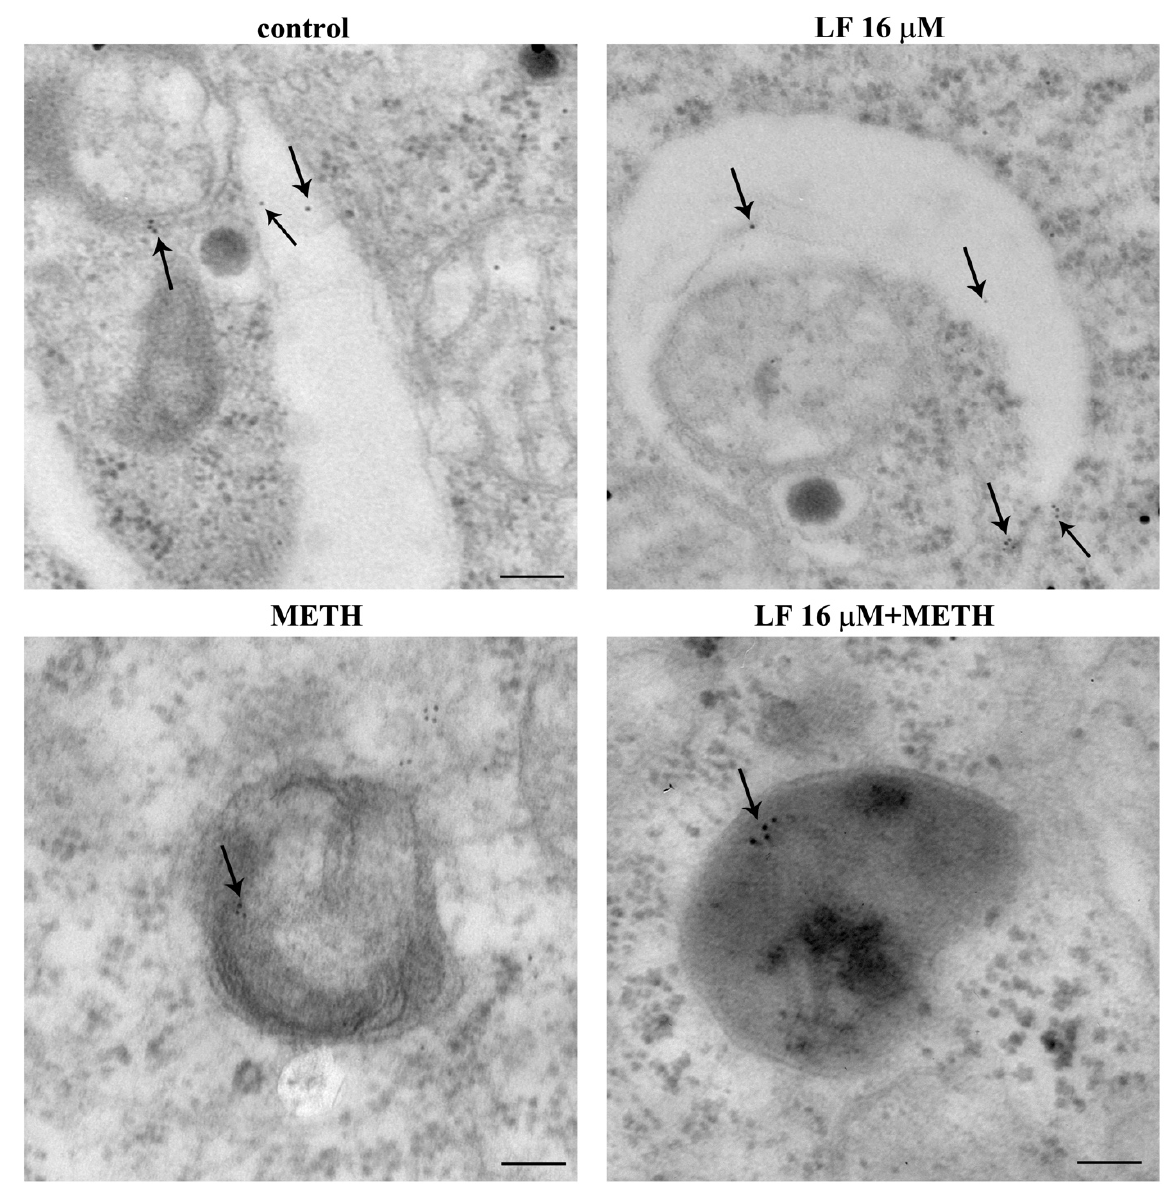
Figure 15. Lactoferrin increases LAMP1 compartmentalization within vacuoles. Representative TEM pictures of LAMP1 positive vacuoles from a control cell, and cells treated with either LF 16 µ M or METH or LF + METH. Arrows point to LAMP1 immuno-gold particles within vacuoles. Scale bar = 100 nm (control and LF 16 µ M); 200 nm (METH); 65 nm (LF 16 µ M + METH).